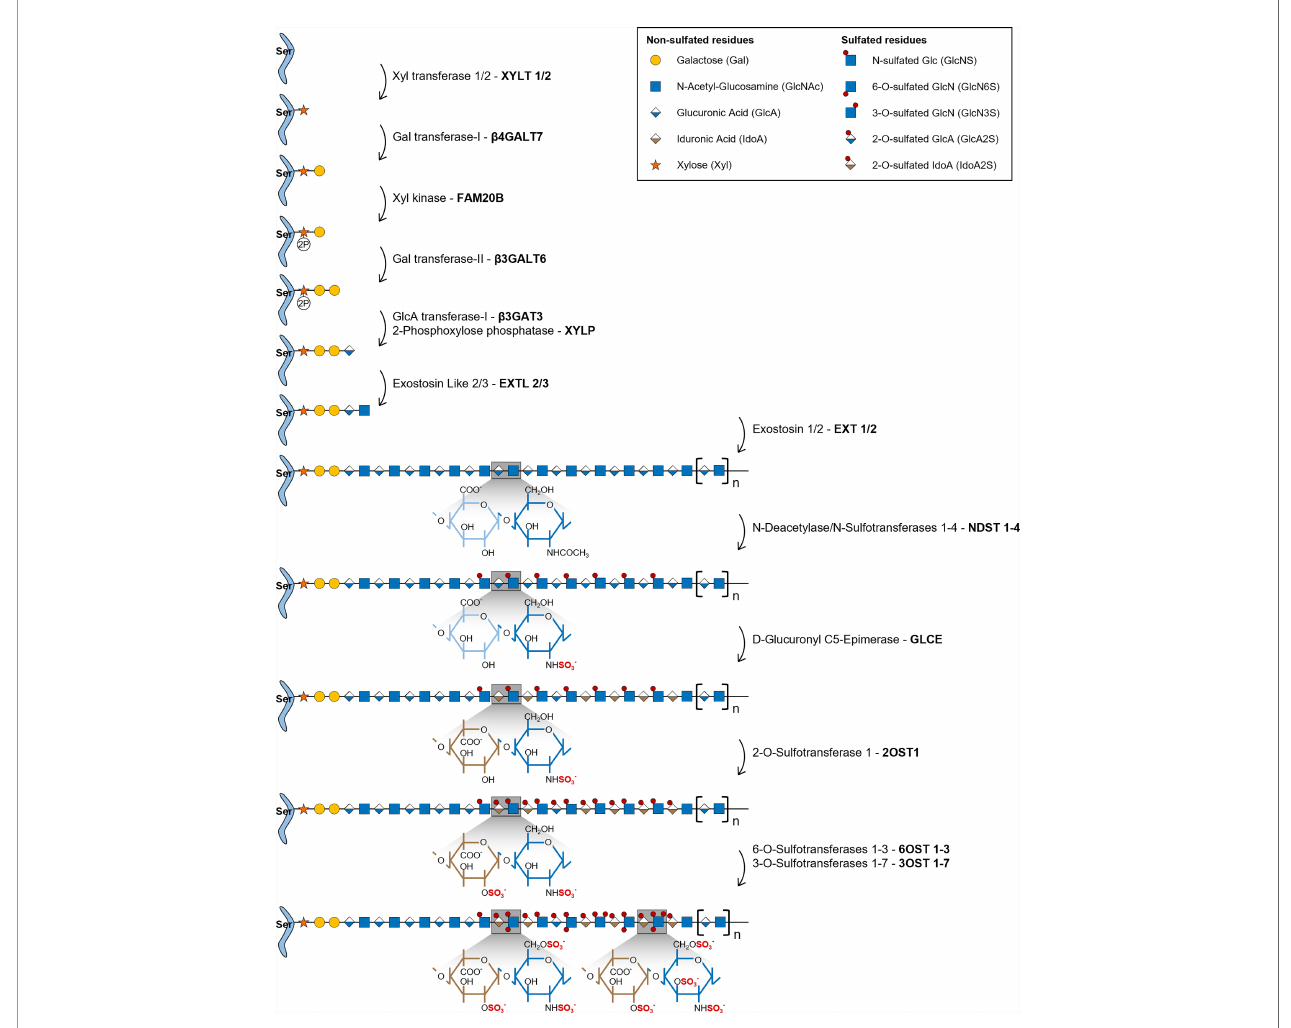
FIGURE 1 | Illustrative representation of the HS biosynthetic pathway and the disaccharide structural changes that occur during each modi fi cation reaction. HS biosynthesis comprises the stepwise transfer of different sugar residues that leads to the elongation of HS chains. In the last stage of this biosynthetic pathway, polymerized HS chains undergo multiple modi fi cation reactions: i) NDSTs 1-4 catalyse the removal of the acetyl group from GlcNAc residues and the transfer of a sulfate group to free amino groups to form GlcNS; ii) GLCE epimerizes GlcA residues into IdoA; iii) these residues are then targeted by 2OST1, that transfers sulfate groups to the C2-position of IdoA (more rarely GlcA),thereby preventing further epimerization; iv) lastly, 6OSTs 1-3 and 3OSTs 1-7 add sulfate groups to the C6- and C3-positions of GlcN residues, respectively. Chains non-reducing termini are to the right of the saccharide ’ s sequences. Glycan structures are represented according to the Symbol Nomenclature for Glycans (SNFG)